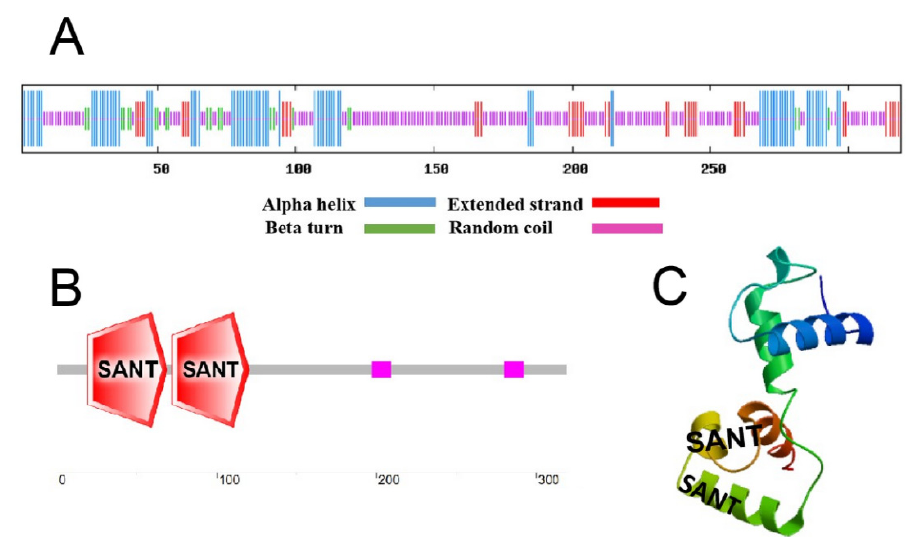
Figure 2. Prediction of FvMYB82 protein domains and structure. ( A ) Predicted protein secondary structure; ( B ) predicted protein domains; ( C ) predicted tertiary structure.